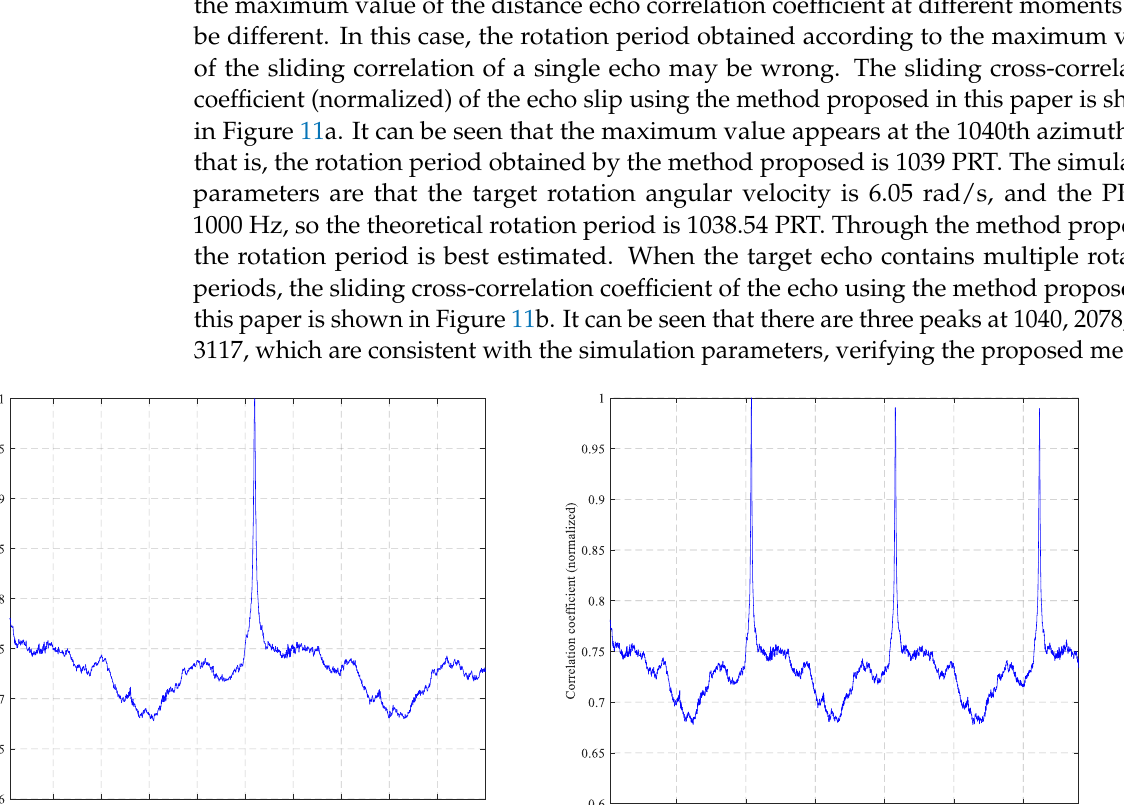
Figure 11. The estimation of the rotation period by the proposed method. ( a ) The echo contains two rotation periods. ( b ) The echo contains multiple rotation